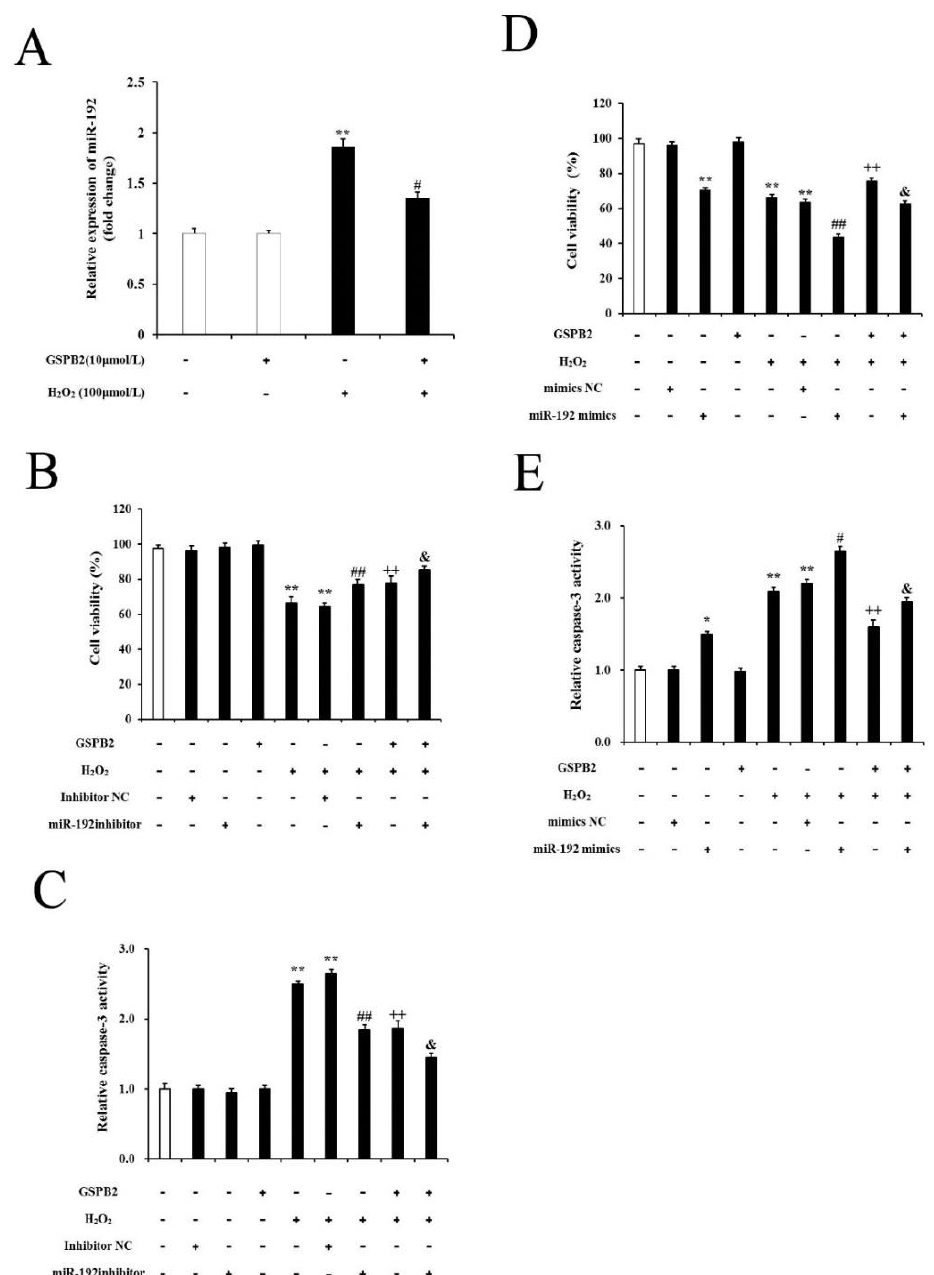
Figure 12. GSPB2 counteracts H 2 O 2 -induced PGC injury through the regulation of miR-192. ( A ) PGCs were pretreated with or without GSPB2 (10 µ M) for 12 h, rinsed in PBS, and then, in- cubated with 100 µ M H 2 O 2 for 12 h. The expression of miR-192 was determined via qRT-PCR. Data are shown as mean ± SE. ( n = 3). ** p < 0.01 vs. the control; ## p < 0.05 vs. H 2 O 2 group. ( B ) PGCs were transfected with miR-192 inhibitor for 24 h; then, they were treated with or without GSPB2 (10 µ M) for 12 h, and finally, incubated with H 2 O 2 (100 µ M) for 12 h. A CCK-8 assay was used to determine PGC viability. ( C ) PGCs were treated as above. The detection of caspase-3 activity was conducted via ELISA assay. ( D ) PGCs were transfected with miR-192 mimic for 24 h; then, they were treated with or without GSPB2 (10 µ M) for 12 h, and finally, incubated with H 2 O 2 (100 µ M) for 12 h. PGC viability was determined via CCK-8 assay. ( E ) PGCs were treated as above. Caspase-3 activity was measured via ELISA assay. Data are shown as mean ± SE. ( n = 3). ** p < 0.01 vs. the